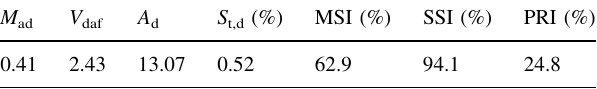
Table 1 Proximate analysis and basic properties parameters of